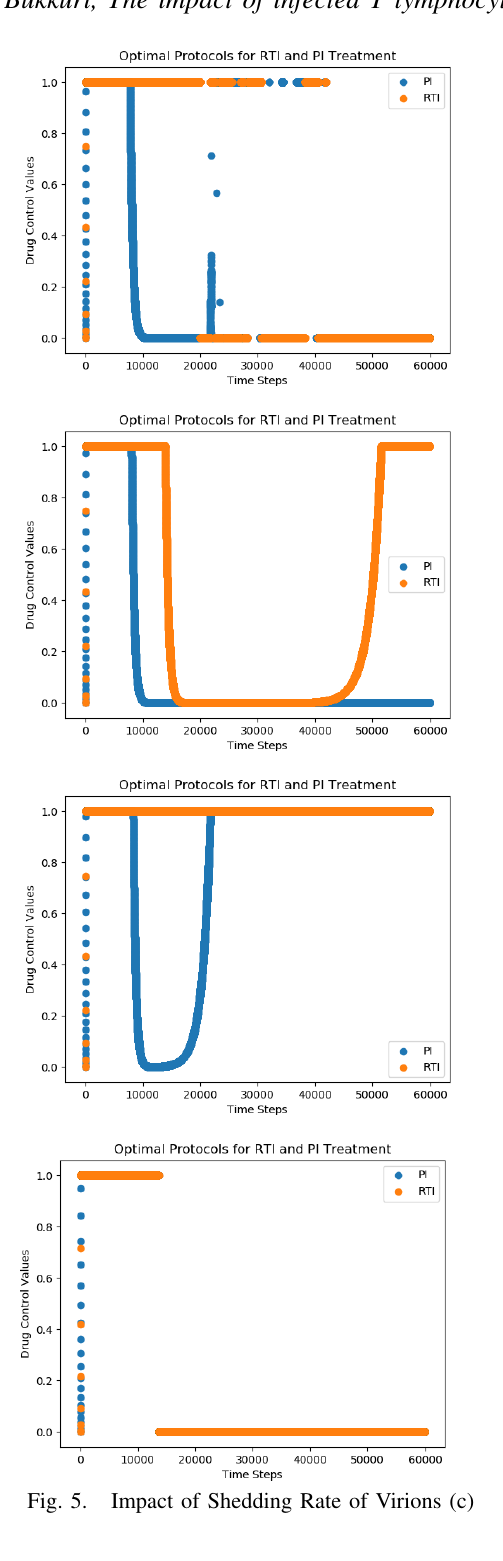
Fig. 5. Impact of Shedding Rate of Virions